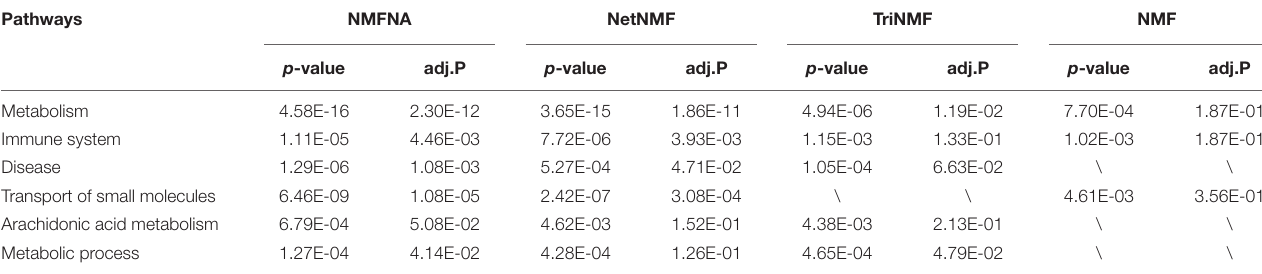
TABLE 3 | Common pathways appearing in at least three out of four methods. Pathways